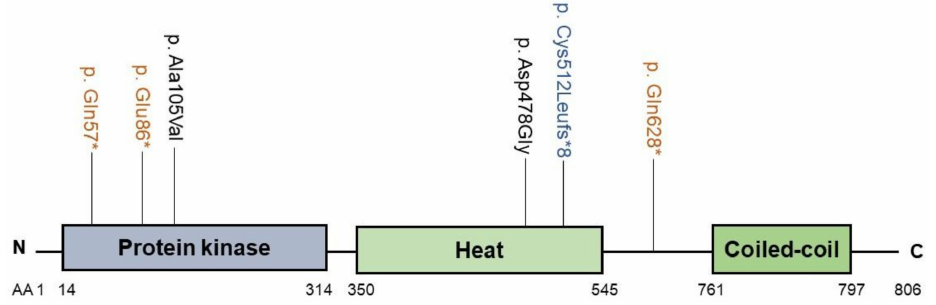
Figure 7. Cholestasis-associated SCYL1 mutations. The protein kinase domain (purple), heat domain (light green) and coiled-coil domain (green) are shown. N: aminoterminus; C: carboxylterminus; AA: amino acid; *: premature